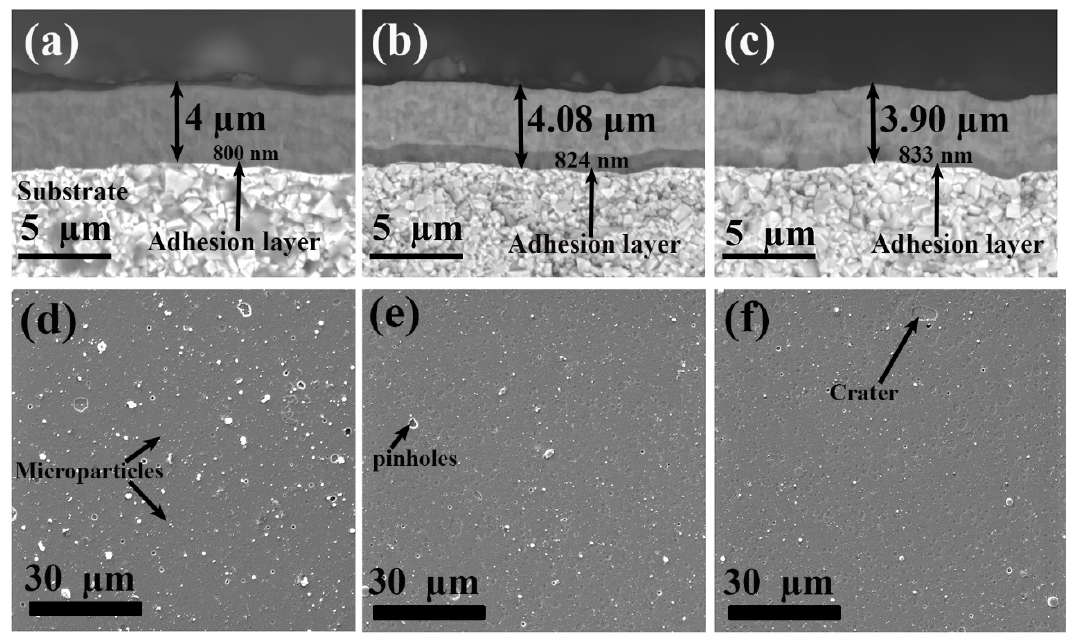
Figure 1. Cross-sectional on coated cemented carbide (CC) substrates and surface morphology on the coated high-speed steel (HSS) substrates ( a , d ) AlCrN coating ( b , e ) AlCrMoN coating, and ( c , f ) AlCrVN coating.